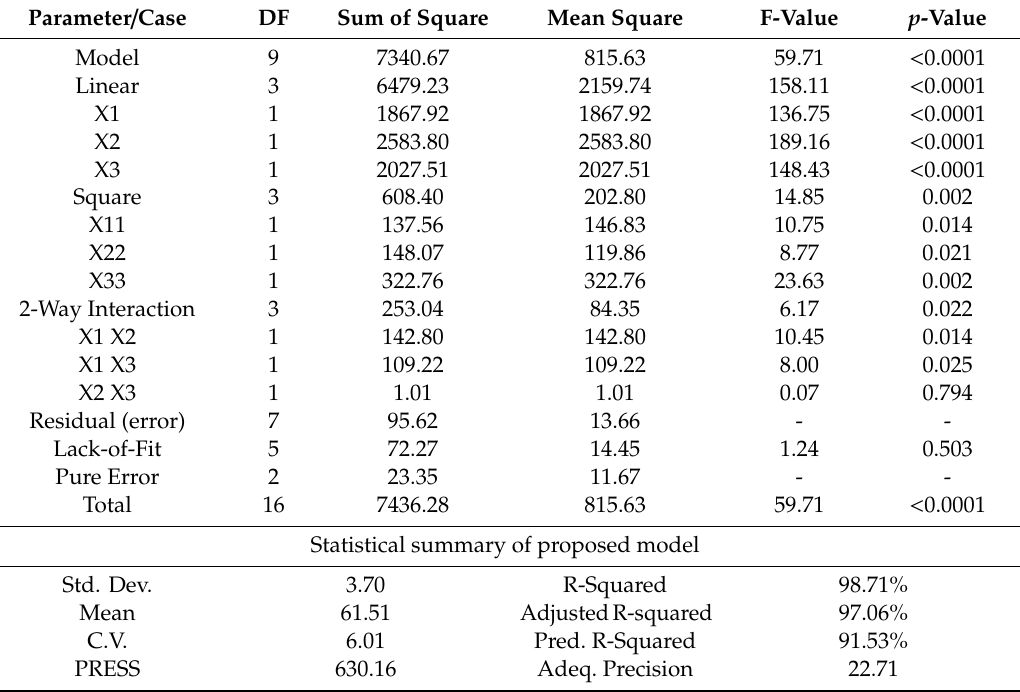
Table 2. Analysis of variance